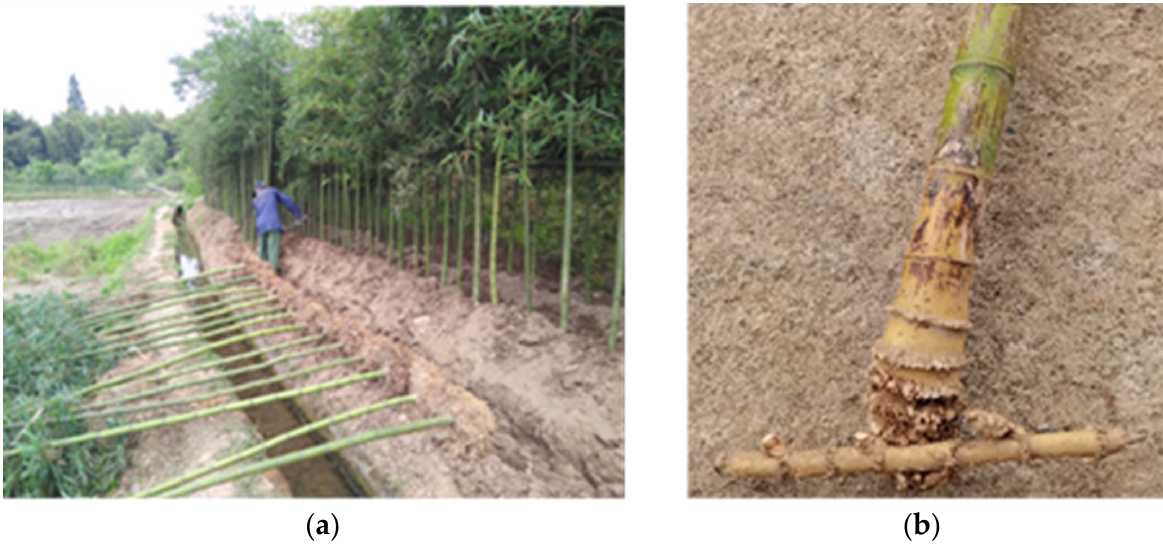
Figure 1. Mother bamboo. ( a ) Artificial planting of mother bamboo for potting; ( b ) mother bamboo.